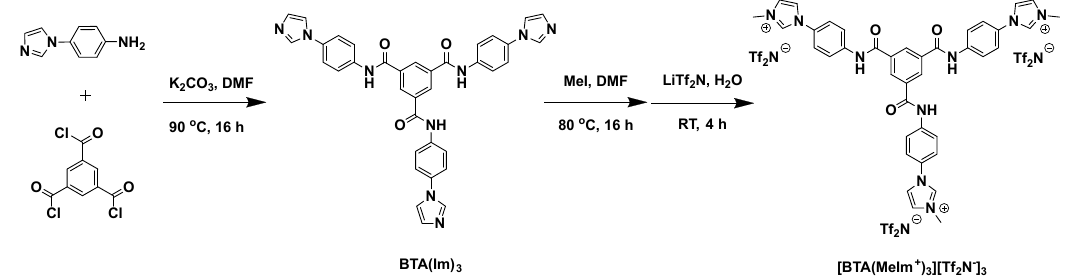
Scheme 1. Synthesis of poly(imide-amide) and poly(amides) from bis(imidazole) and diamide dichloride linkage, polymerized via the Menshutkin